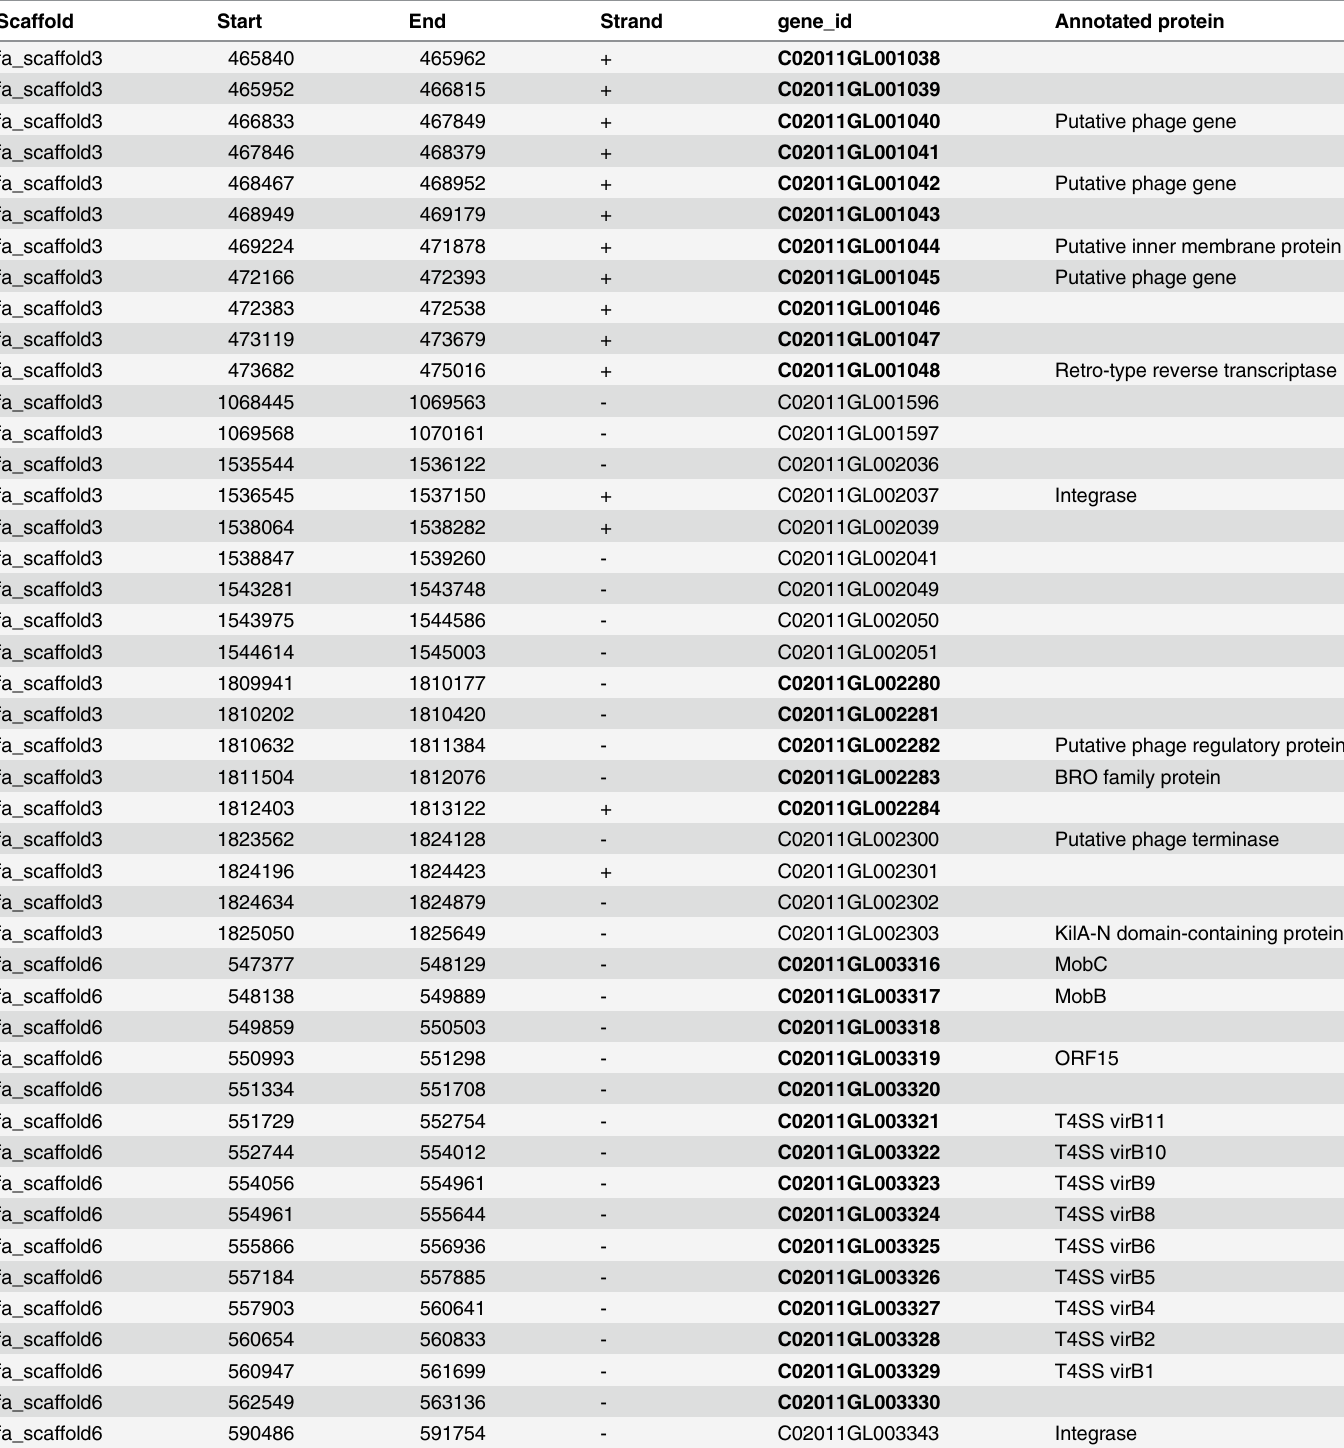
Table 4. 45 genes specific in P . mirabilis